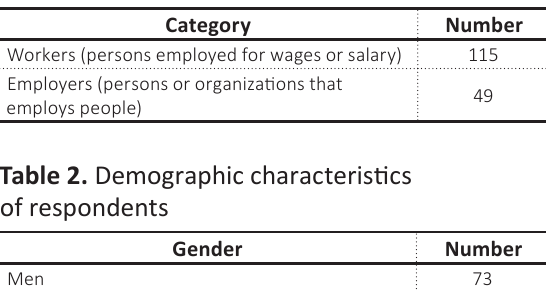
Table 1. Total number of interviewed respondents